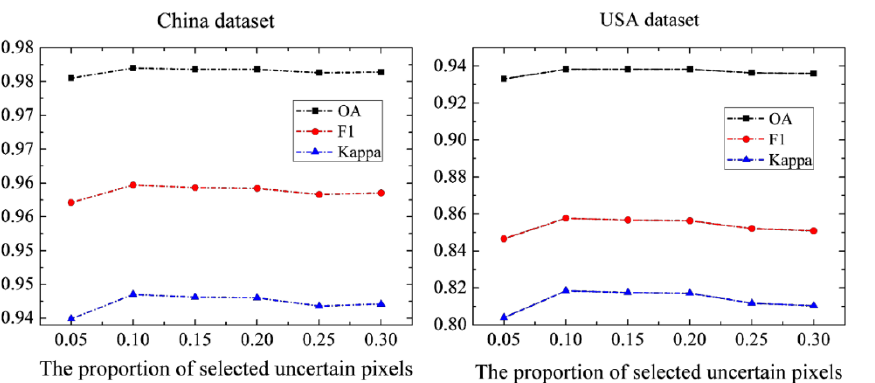
Figure 14. SSCF experiments using different proportions of uncertain pixels.